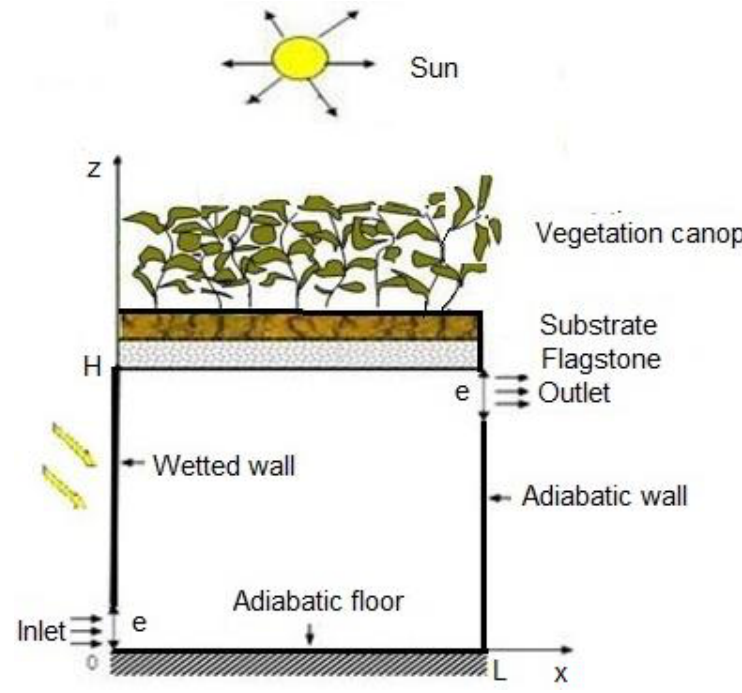
Figure 1 . A schematic diagram for the